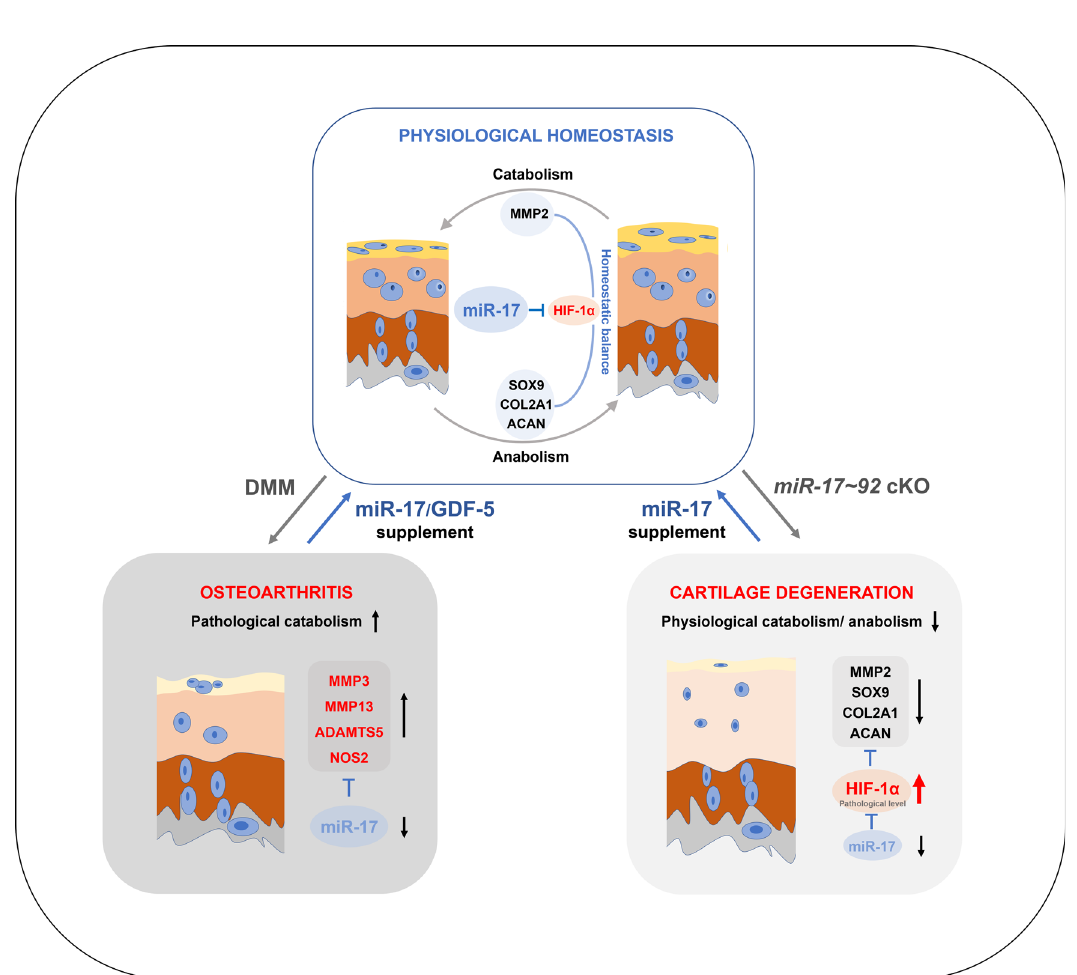
Fig. 7 Model depicting the mechanisms of miR-17 in maintaining cartilage homeostasis and prevention of OA. MiR-17 is a regulator for HIF-1 α in articular chondrocytes, and catabolic and anabolic balance was maintained under physiological HIF-1 α expression. The cellular and ECM change of the articular cartilage was shown in mouse models of DMM or miR-17~92 cKO. The faded color in super fi cial and middle layers indicates ECM destruction or degeneration. In DMM-induced OA, pathological catabolic factors targeted by miR-17 were increased. In miR-17~92 cKO mice, miR-17 de fi ciency caused pathological increase of HIF-1 α , and decreased the physiological catabolism and anabolism in chondrocytes. Supplementation with exogenous miR-17 or inducing endogenous miR-17 by GDF-5 treatment prevented OA and restored cartilage homeostasis.